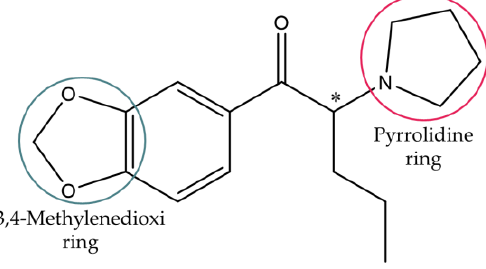
Figure 2. Chemical structure of MDPV.